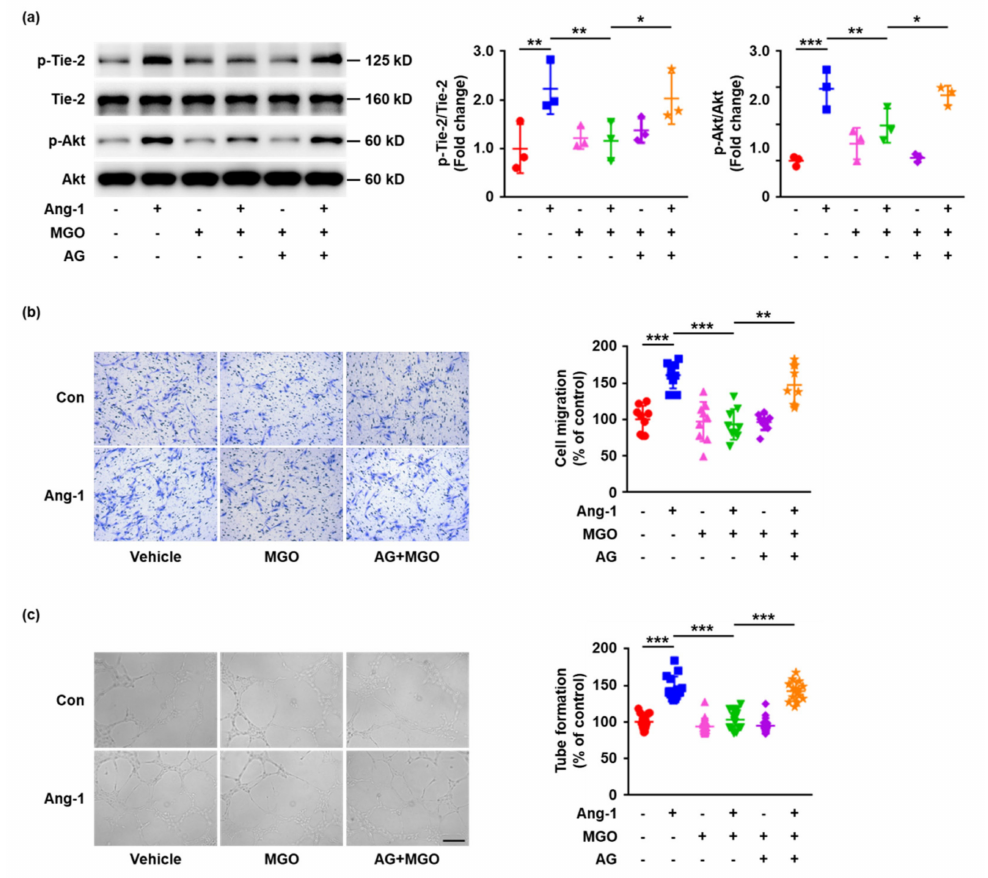
Figure 4. AG prevents MGO–induced Ang-1/Tie-2 signaling dysfunction. ( a ) HUVECs were pre- treated with AG (100 µ M) or vehicle control for 1 h and then exposed to MGO (100 µ M) for 24 h, followed by stimulation with Ang-1 (200 ng/mL) or vehicle control for 15 min. Phosphorylation (p) of Tie-2 and Akt and total Tie-2 and Akt were detected by Western blotting. Representative images of three independent experiments are shown and densitometric analysis of phosphorylated Tie-2 and Akt normalized to total Tie-2 and Akt was performed. ( b ) HUVECs cultured in six-well plates were pre-treated with AG (100 µ M) or vehicle control for 1 h, followed by exposure to MGO (100 µ M) for 24 h. The cells were then detached and added to the upper chambers containing porous filters, followed by stimulation with Ang-1 (200 ng/mL) or vehicle control. After 24 h, the cells were fixed, stained, and the cells that had migrated to the lower chambers were counted. Representative images of three independent experiments are shown and quantitative assessment was performed. Distance bars, 200 µ m. ( c ) HUVECs cultured in six-well plates were pre-treated with AG (100 µ M) or vehicle control for 1 h, followed by exposure to MGO (100 µ M) for 24 h. The cells were then detached and seeded onto Matrigel in the presence of Ang-1 (200 ng/mL) or vehicle control for 18 h. Representative images of three independent experiments are shown and the quantitative assessment was